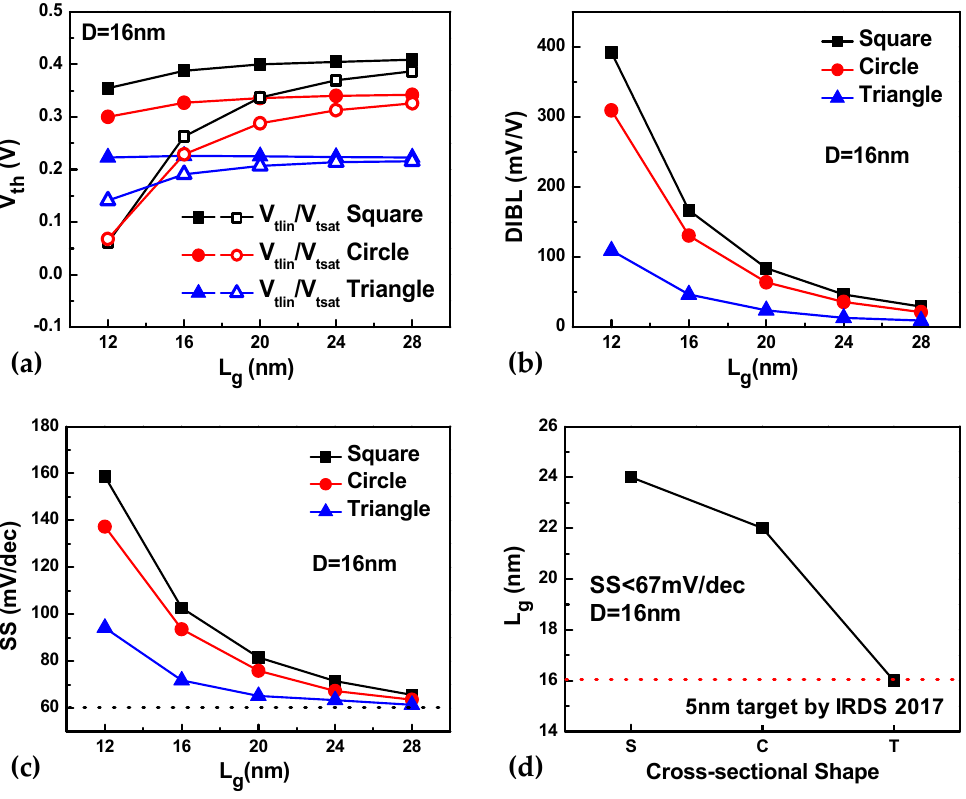
Figure 2. ( a – c ) The trend of V th , SS, and DIBL for different cross-sectional shapes of GAA SNWTs as a function of gate length; ( d ) The ability to scale down GAA FETs with different cross-sections.